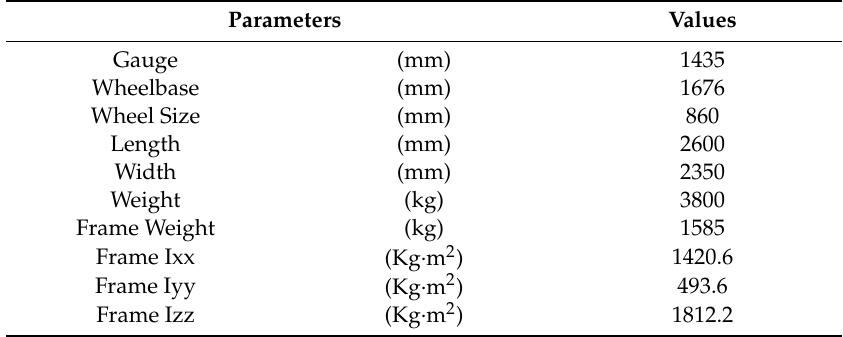
Table 1. The specification of 3-piece bogie frame [21].